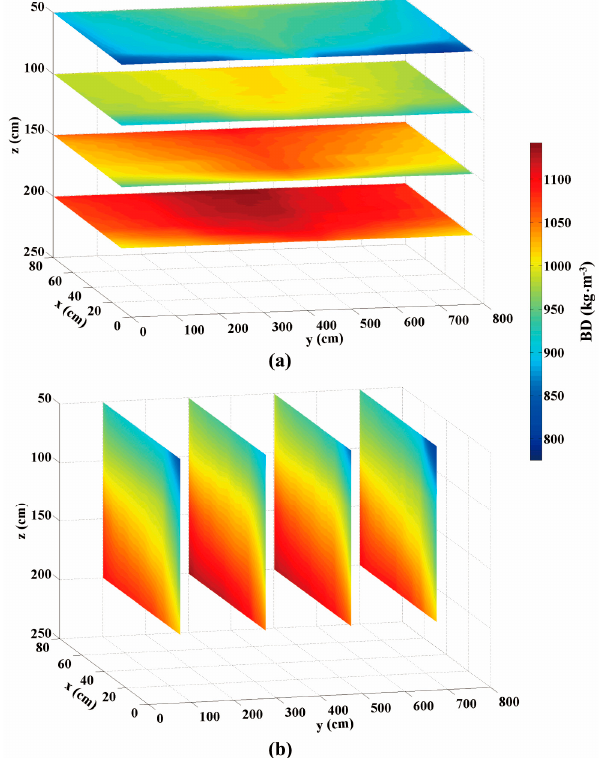
Figure 10. Silage BD maps generated for ( a ) horizontal- and ( b ) vertical-distributions.